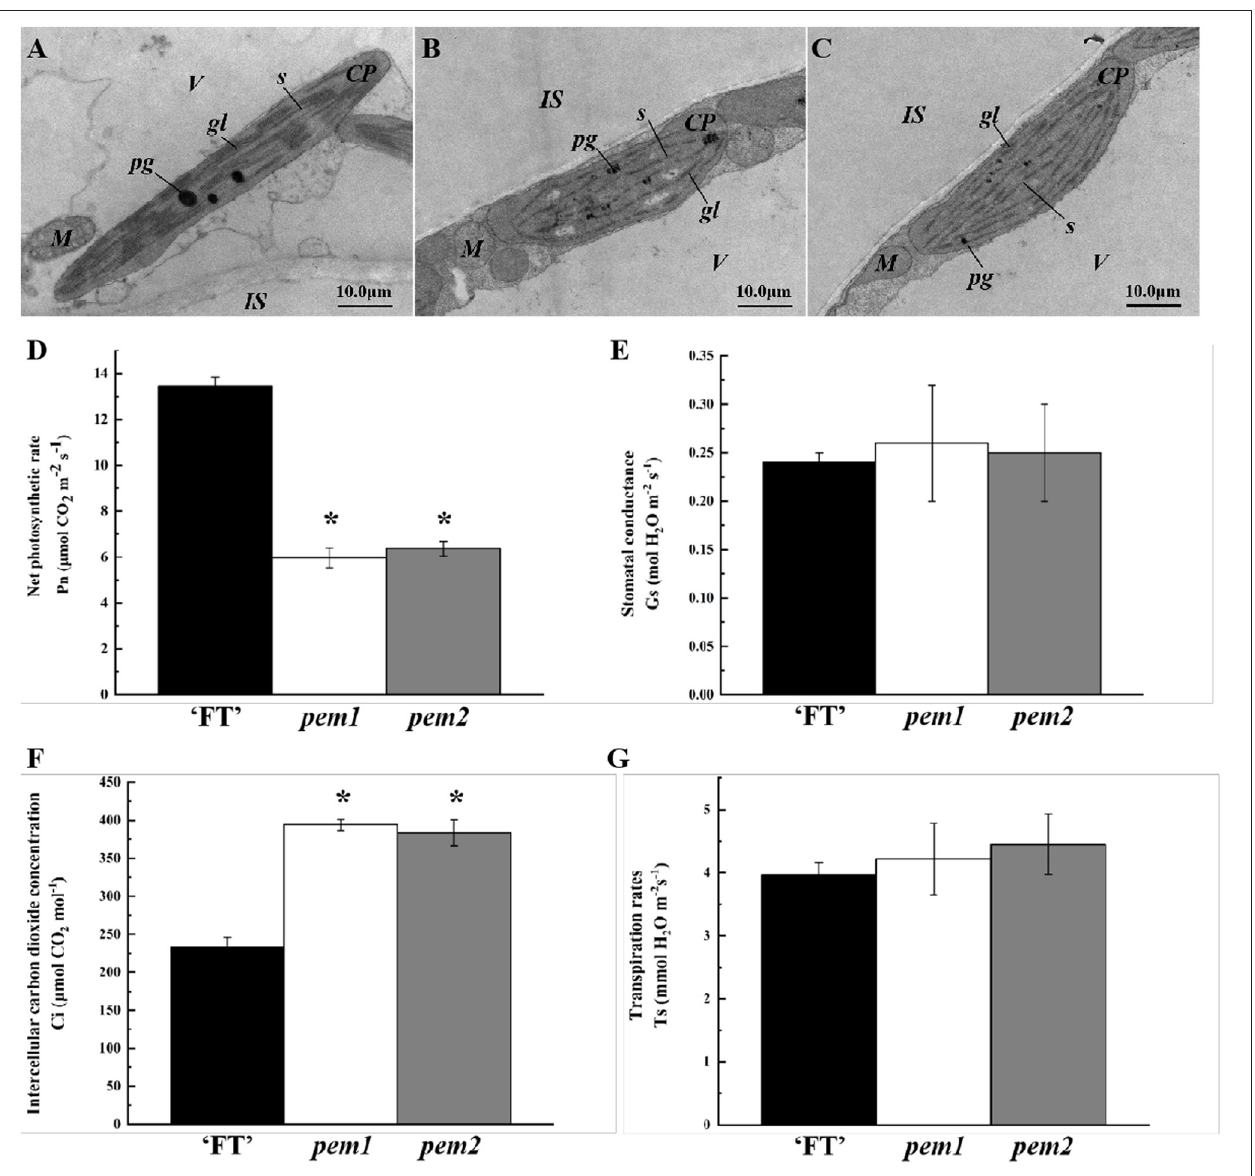
FIGURE 2 | Ultrastructure of chloroplasts and photosynthetic characteristics in pem1 and pem2 compared with “FT” in Chinese cabbage. Mesophyll cells of “FT” (A) , pem1 (B) , and pem2 (C) were visualized with TEM (magnification, × 50,000). cp , chloroplast; gl , grana lamella; is , intercellular space; m , mitochondria; pg , plastoglobule; s , stroma; v , vacuole. Scale is shown at the bottom right. Photosynthetic characteristics: net photosynthetic rates (D) , stomatal conductance (E) , intercellular carbon dioxide concentrations (F) , and transpiration rates (G) of pem1 and pem2 compared with the wild-type “FT.” *indicate significant differences at 5%